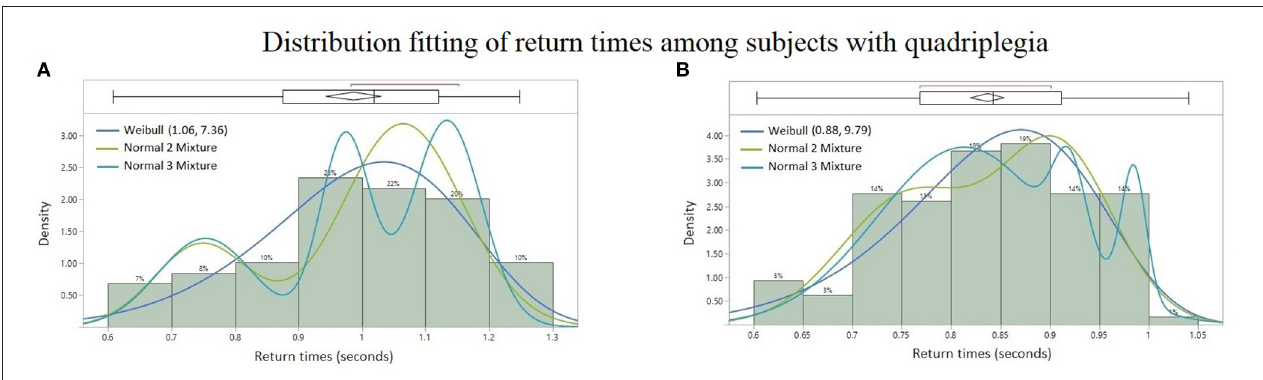
FIGURE 7 | Probability distribution fitting of return times from patients with quadriplegia: (A) Thoracic signal of Subject #2 with Weibull ( AICc = − 45.69), Normal 2 Mixture ( AICc = − 41.36), and Normal 3 Mixture ( AICc = − 35.46), (B) lumbar spine signal of Subject #1 with Weibull ( AICc = − 231.43), Normal 2 Mixture ( AICc = − 227.36), and Normal 3 Mixture ( AICc = − 227.12). Lower AICc values indicate a better distribution fit.